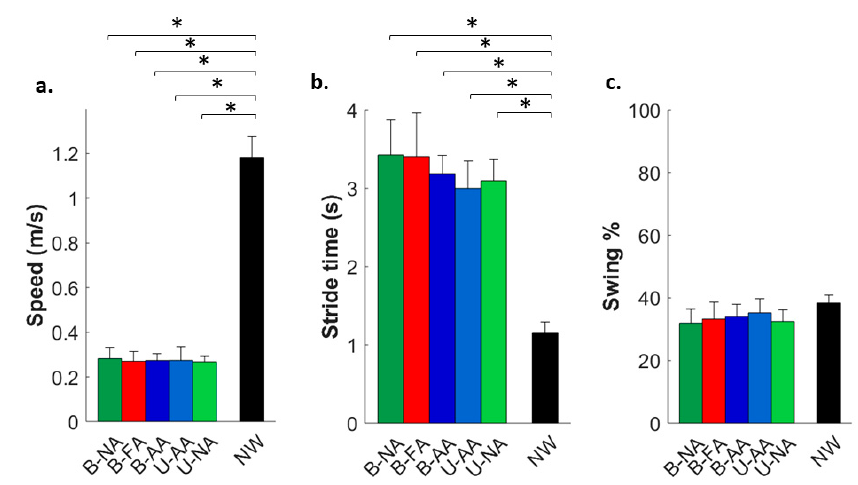
Figure 3. ( a ) Mean ± standard walking speed (m / s); ( b ) Mean ± standard stride duration (s); ( c ) Mean ± standard swing phase duration expressed as percentage of the gait cycle. Colors indicate the different walking modalities: black for normal walking without the Ekso (NW); the other colors refer to walking with the Ekso with bilateral no assistance (B-NA, dark green), bilateral full assistance (B-FA, red), bilateral adaptive assistance (B-AA, dark blue), unilateral adaptive assistance (U-AA, light blue), and unilateral no assistance (U-NA, light green). * indicates p < 0.0001.